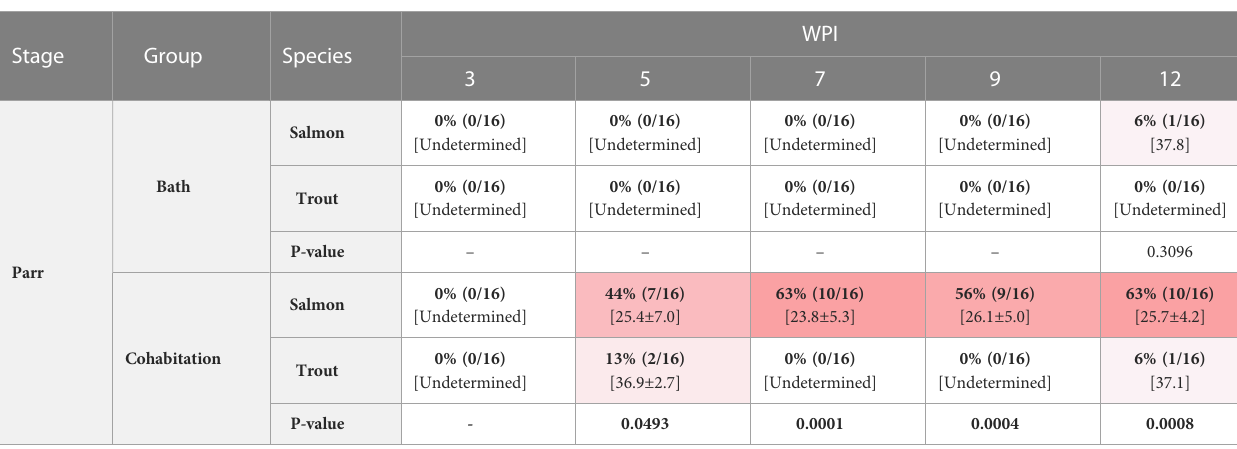
TABLE 3 The prevalence of PRV-1 positive salmon and trout parr at 3, 5, 7, 9, and 12 WPI.